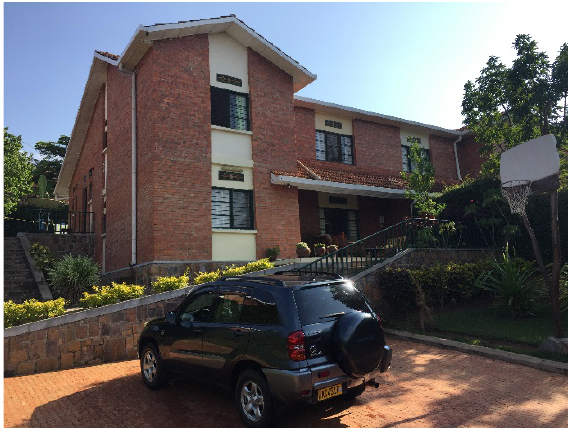
Figure 37. Twin House Type 1: Front yard. Photograph by Manlio Michieletto.